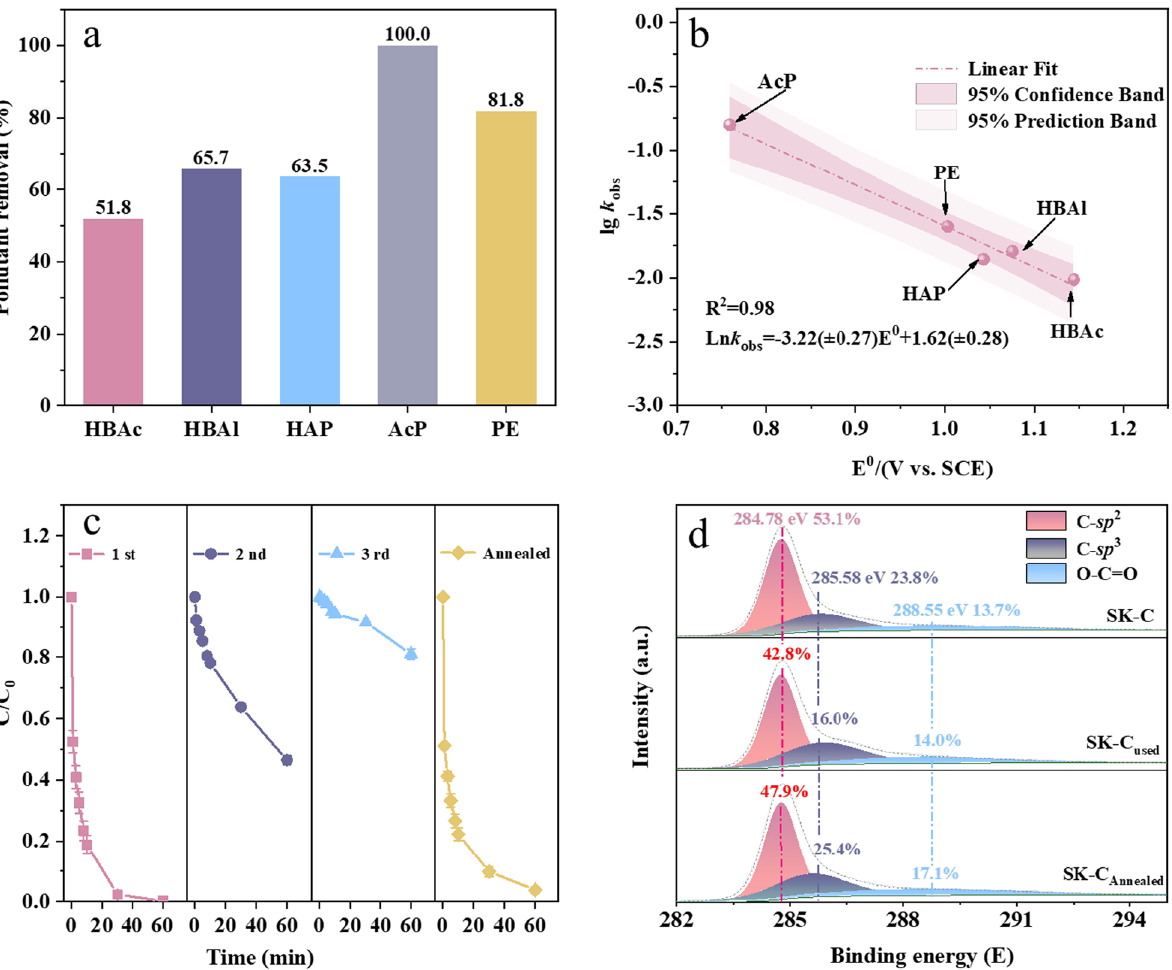
Fig. 5 Degradation curves of different PCs ( a ) and correlation of k obs to the standard electrode potentials of pollutants ( b ) by the PDS/SK-C system. Reusability of SK-C/PDS system for SDZ degradation ( c ). C 1 s XPS spectra of SK-C, SK-C used and SK-C annealed (after three cycles) ( d ). Experimental conditions: [PDS] 0 2 mM, [Catalyst] 0 0.1 g L − 1 , [PCs] 0 20 mg L − 1 , T 25 = = = =